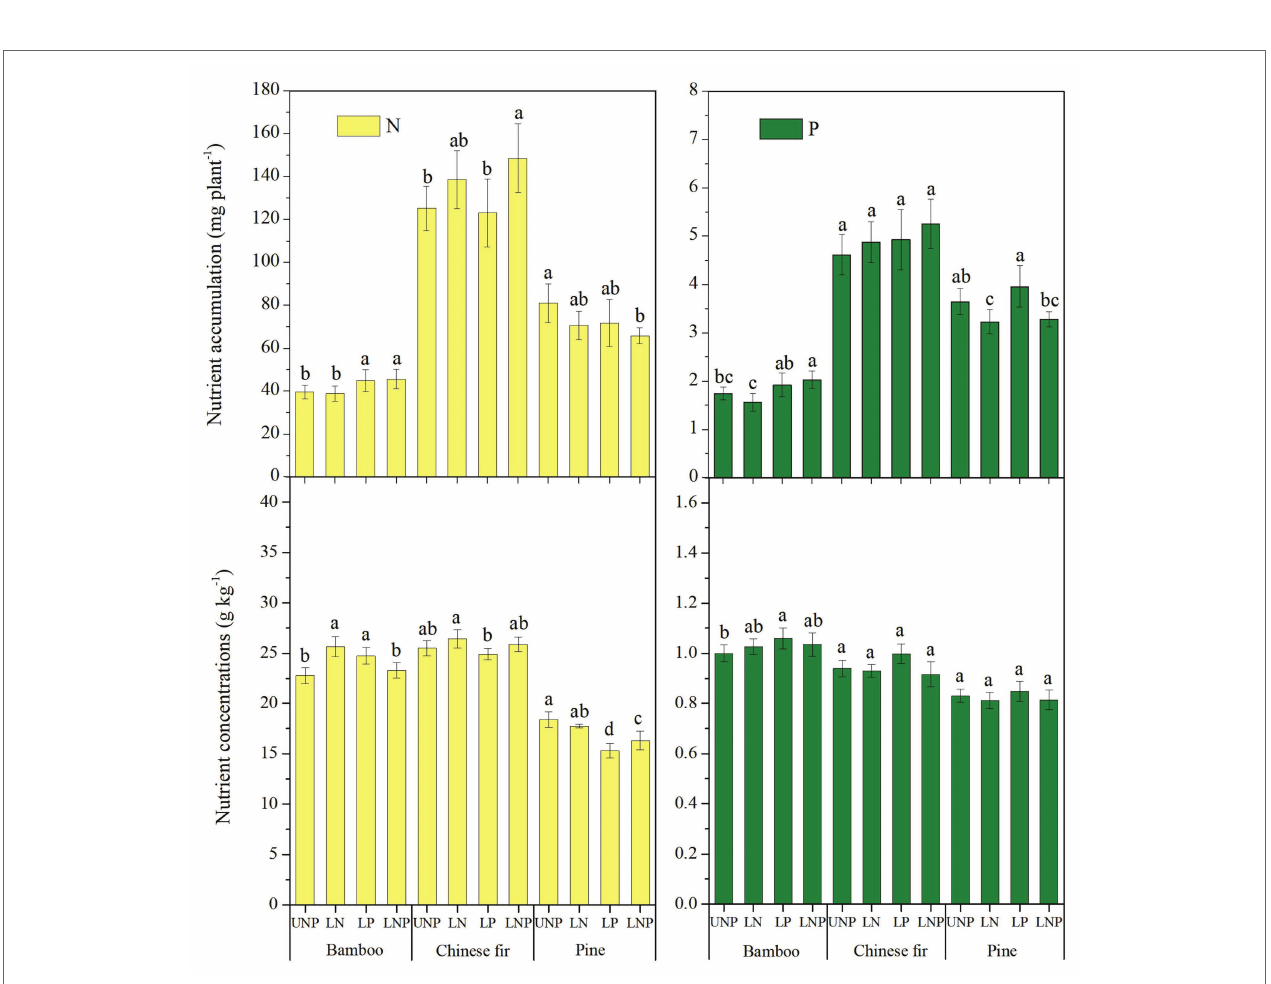
FIGURE 8 | Total nutrients content and average nutrient concentrations of the three tree species under the four nutrient supply treatments. Different lowercase letters denote significant differences among treatments ( p <